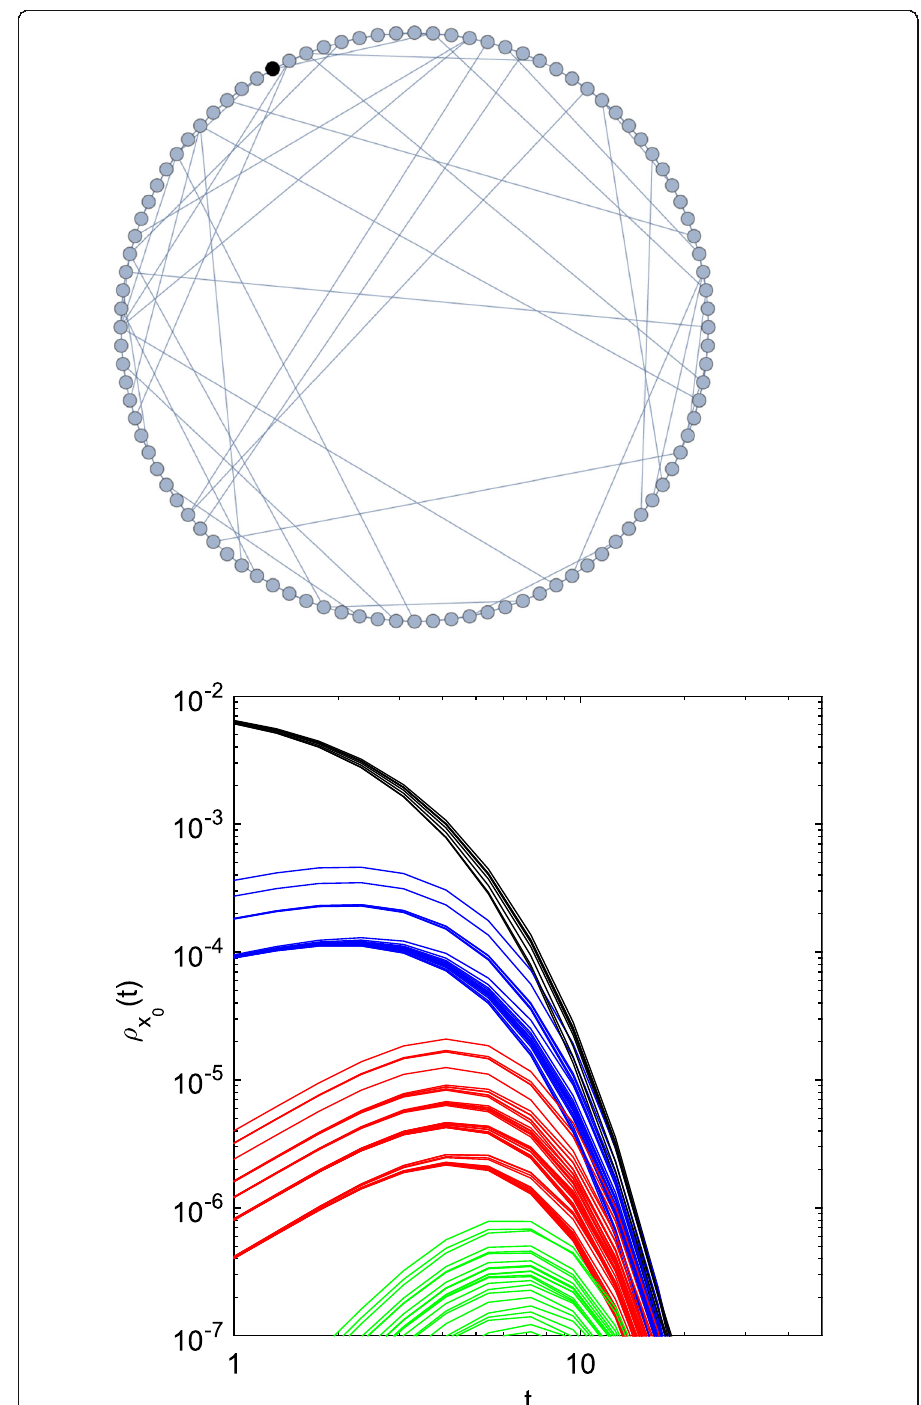
Fig. 7 (Top) Example of a WS network model with β = 0.2; k = 8; N = 100, with a fixed absorbing node x a , marked by black circle. (Bottom) FPT densities for this network with homogeneous travel time distributions ~ ψ ð s Þ ¼ 1 = ð s τ þ 1 Þ ; τ = 1; for different starting points x xx 0 0 and a fixed absorbing node x a = 1. Different colors correspond to different shortest paths length between x 0 and x a : ∣ x 0 − x a ∣ = 1 (black), ∣ x 0 − x a ∣ = 2 (blue), ∣ x 0 − x a ∣ = 3 (red), ∣ x 0 − x a ∣ = 4